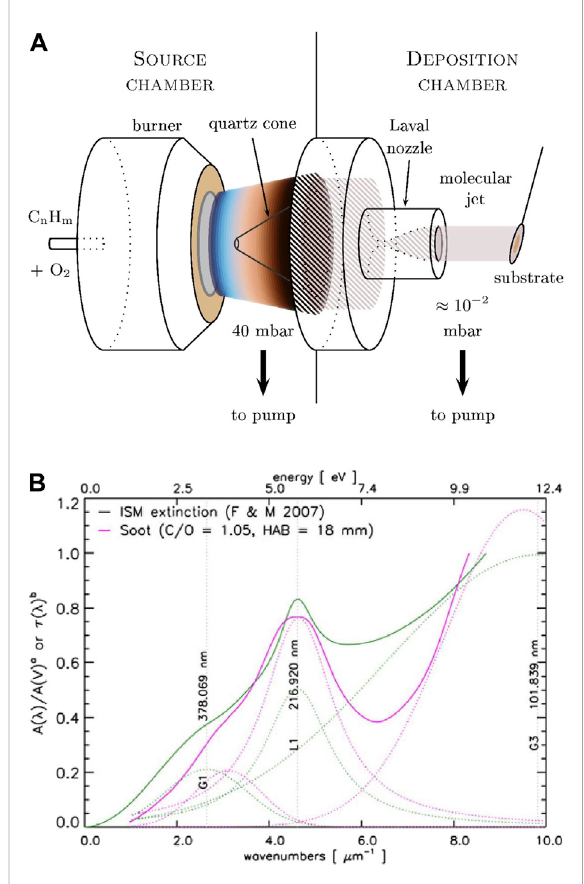
FIGURE 1 (A) : Scheme of the experimental set up used in Gavilan et al., 2016; Gavilan et al., 2017 for the production of soot samples. Premixed fl ames of C 2 H 4 /O 2 are produced at the burner. The soot particles are collected on the substrate (Gavilan et al. Astron. Astrophys., 586, A106, 2016, reproduced with permission © ESO). (B) : Comparison of the average interstellar extinction curve (Fitzpatrick and Massa 2007, green trace), normalized at its maximum, with that of an experimental sample of soot from Gavilanetal.,2017(pinktrace).CurvesL1,G1andG3correspondto a deconvolution of the data. The maximum of L1 corresponds to the217.5 nm(4.6 μ m − 1 )UVbump(Gavilanetal.Astron. Astrophys., 607, A73, 2017, reproduced with permission ©